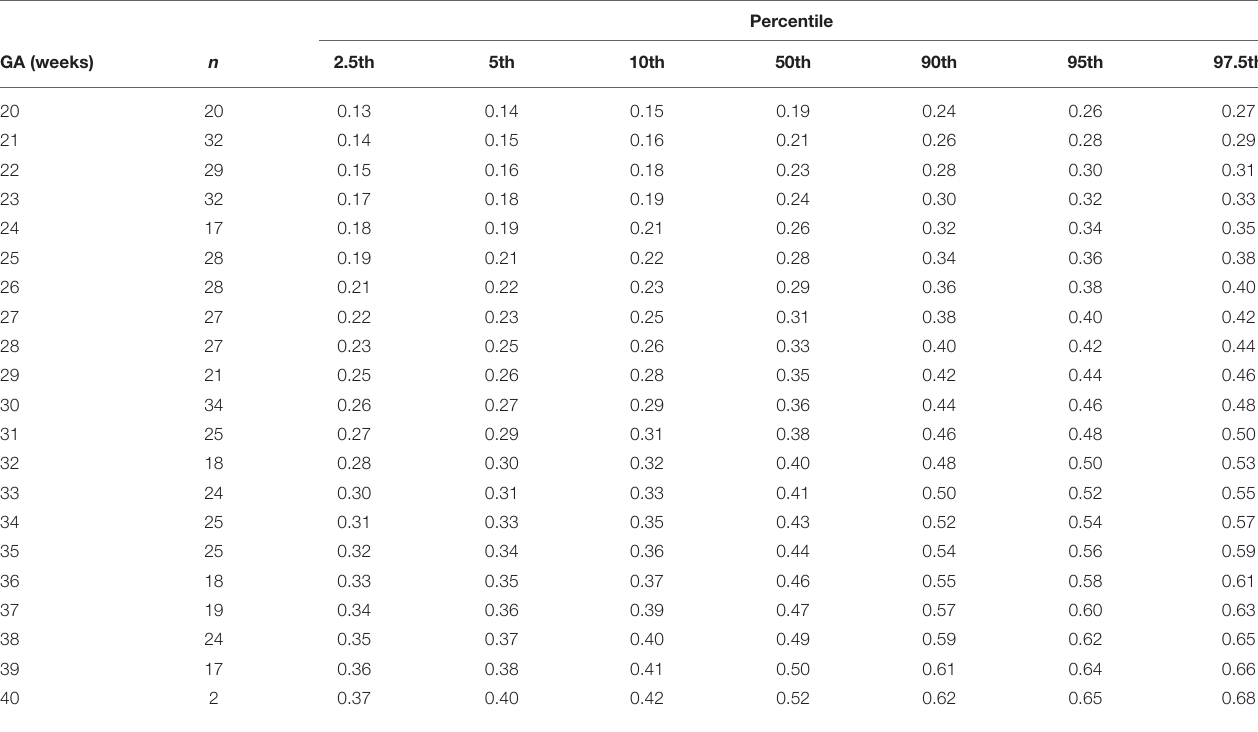
TABLE 2 | Percentiles of fetal superior vena cava diameter (cm) at 20–40 weeks of gestational age